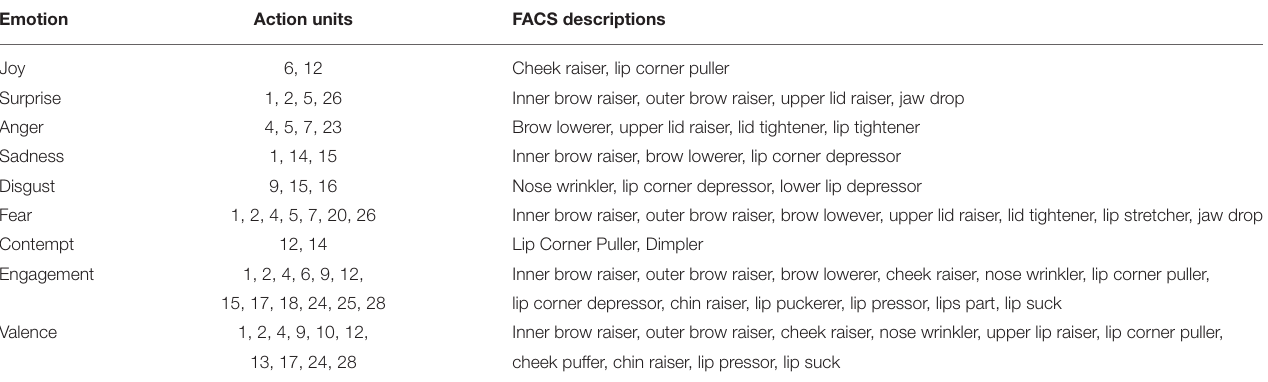
TABLE 1 | Emotions with corresponding Actions units and Facial Action Coding System (FACS) descriptions adapted from Krosschell (2020). Emotion Action units FACS